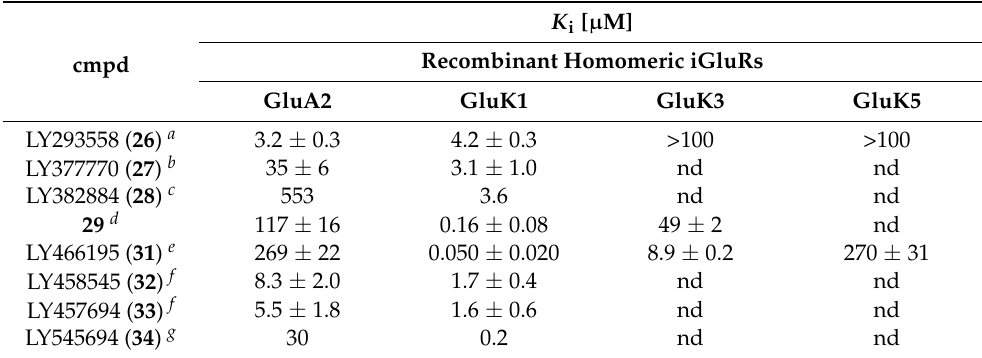
Table 5. Receptor binding affinity of selected cis -decahydroisoquinoline derivatives at recombinant homomeric iGluRs, determined in radioligand binding assays (all values in µ M).